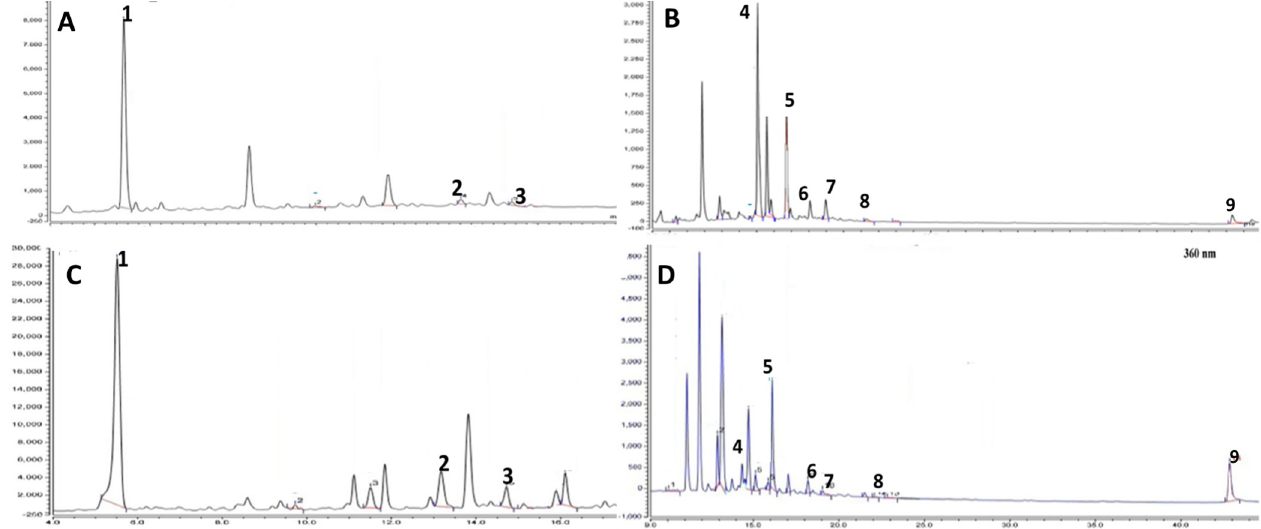
Fig 2. HPLC chromatograms for AEE and REE at λ = 280 and 360 nm. A and B :HPLC analysis for REE showing eluted compounds with UV absorbance at λ = 280 and 360 nm, respectively. C and D : HPLC chromatogram of eluted compounds detected at λ = 280 and 360, respectively. Identified compounds are labeled as 1 : gallic acid, 2 :ellagic acid, 3 : ferulic acid, 4 : umbelliferone, 5 : myricetin, 6 :quercetin, 7 :coumarin, 8 :apigenin and 9 :kaempferol.